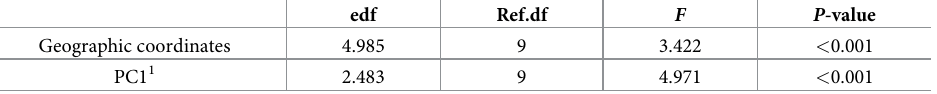
Table 5. Summary of the generalized additive model describing factors influencing white-tailed deer abundance in Adirondack Park, New York, USA, 2016. We present the estimated degrees of freedom (edf), reference degrees of freedom (Ref.df), F statistic, and P -value for each term.